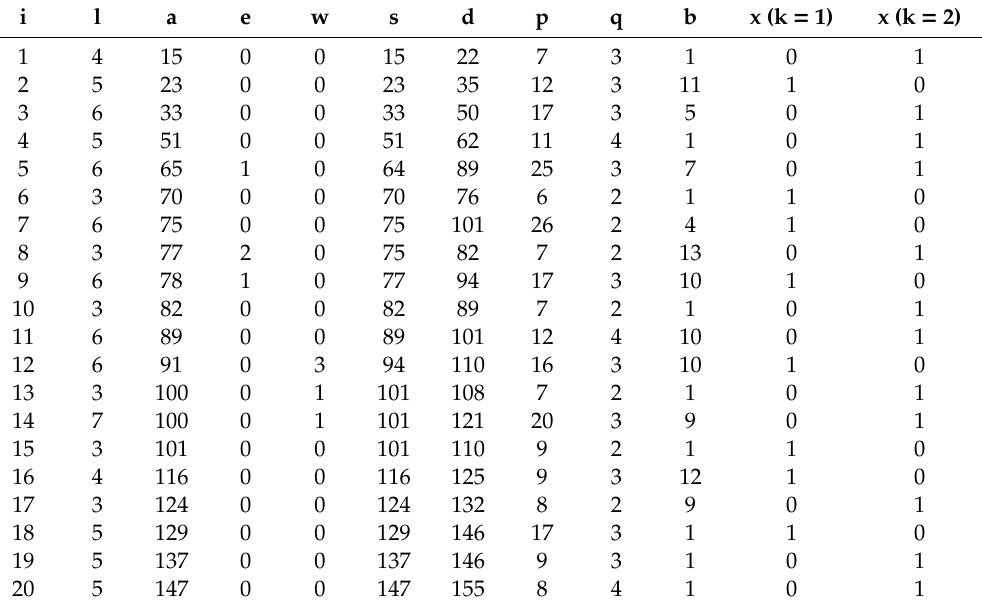
Table A5. Results of the integrated BAP and QCAP solution for Case 10: seed = 700, λ = 3.2, Z (cid:48) =